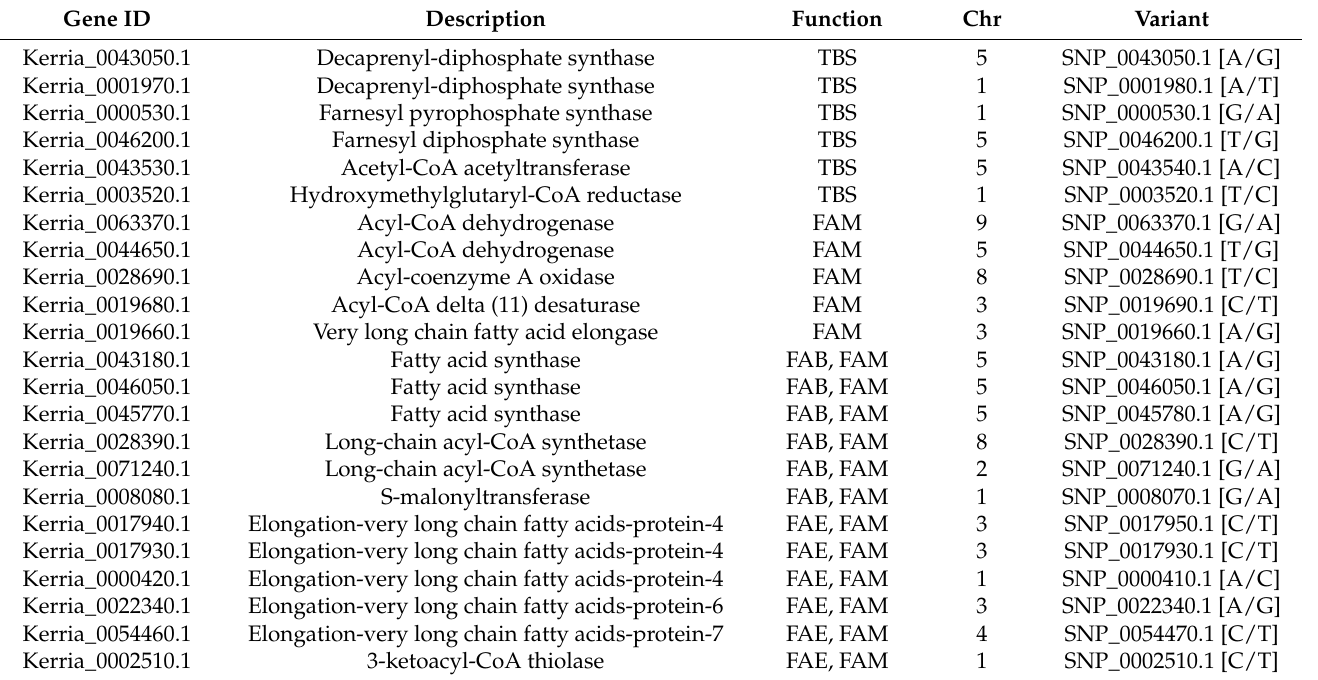
Table 3. Lac production-related candidate genes with SNP